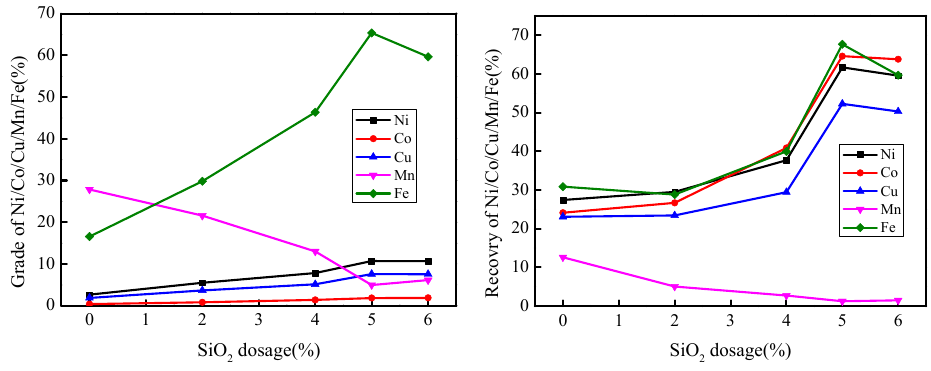
Figure 8. E ff ect of SiO 2 dosage on the concentration of valuable metals. Figure 8. Effect of SiO 2 dosage on the concentration of valuable metals. Figure 8. Effect of SiO 2 dosage on the concentration of valuable metals.